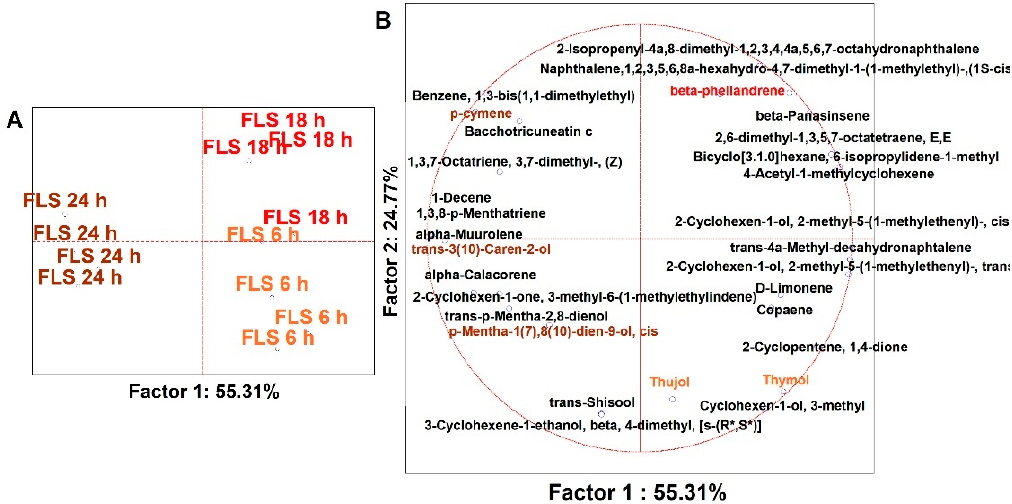
Figure 5. PCAs of the volatilome sorted by alkenes chemical classes of significant (ANOVA p < 0.05) VOCs, including just FLS cases (with technical replicas, n = 4) and three different time points. Values were recorded over and after 24 h of in vitro batch human colonic fermentations with 1% ( w / v ) FLS. ( A ) PCA of cases; ( B ) PCA of variables. In ( B ), the variables with different font colors are the principal descriptors of FLS cases (pale red = FLS 6 h, red = FLS 18 h, dark red = FLS 24 h).